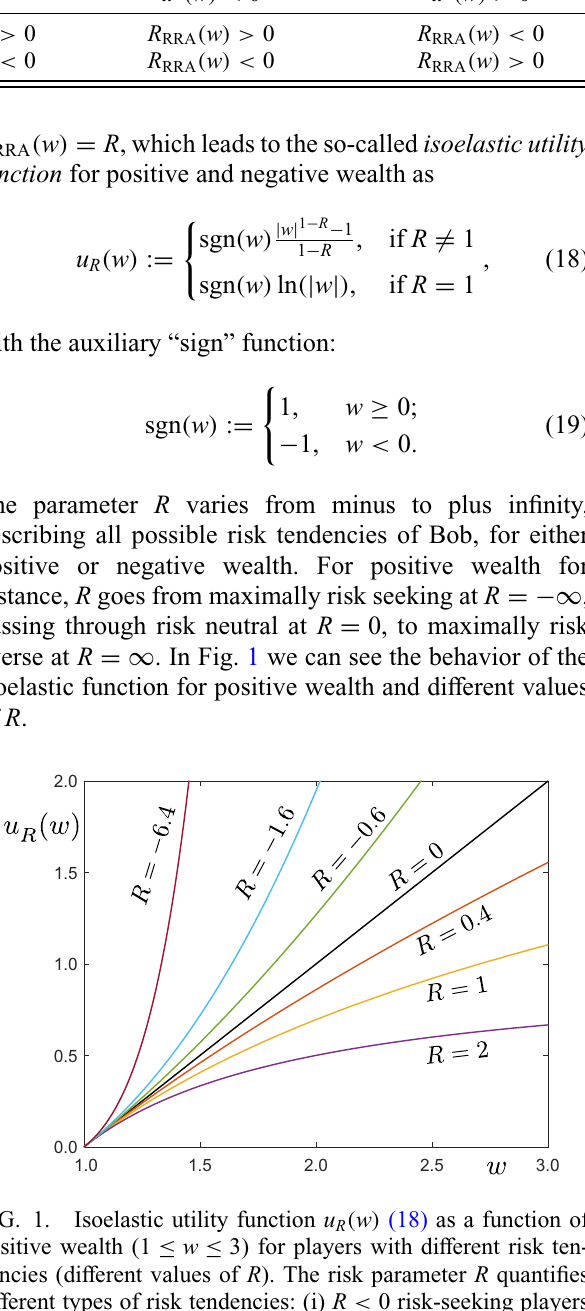
TABLE I. Analysis of the sign of the quantity R RRA ( w ) for the different regimes being considered. We have that the utility func- (cid:11) ( tion is always strictly increasing, meaning that u w ) > 0, and (cid:11)(cid:11) ( therefore we then only need to analyze the signs of w and u w ) . In particular, we have that risk-averse players are represented by positive RRA when dealing with positive wealth, and by negative RRA when dealing with negative wealth. Risk-averse player